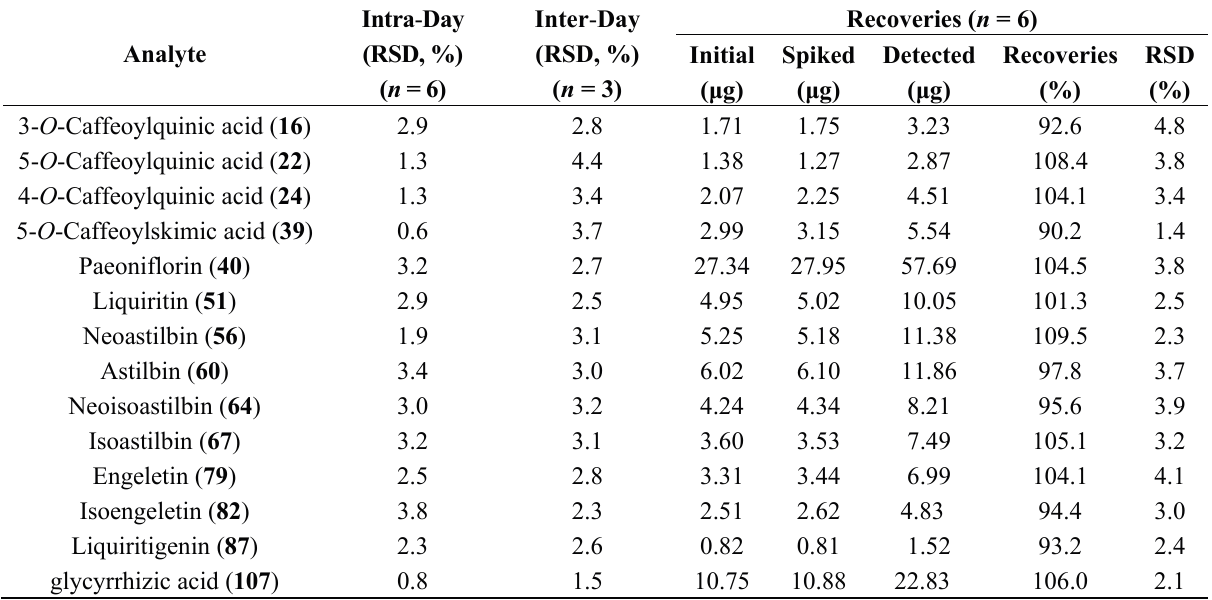
Table 3. Intra-day and inter-day precisions and recoveries for fourteen compounds analyzed with the UHPLC-MS